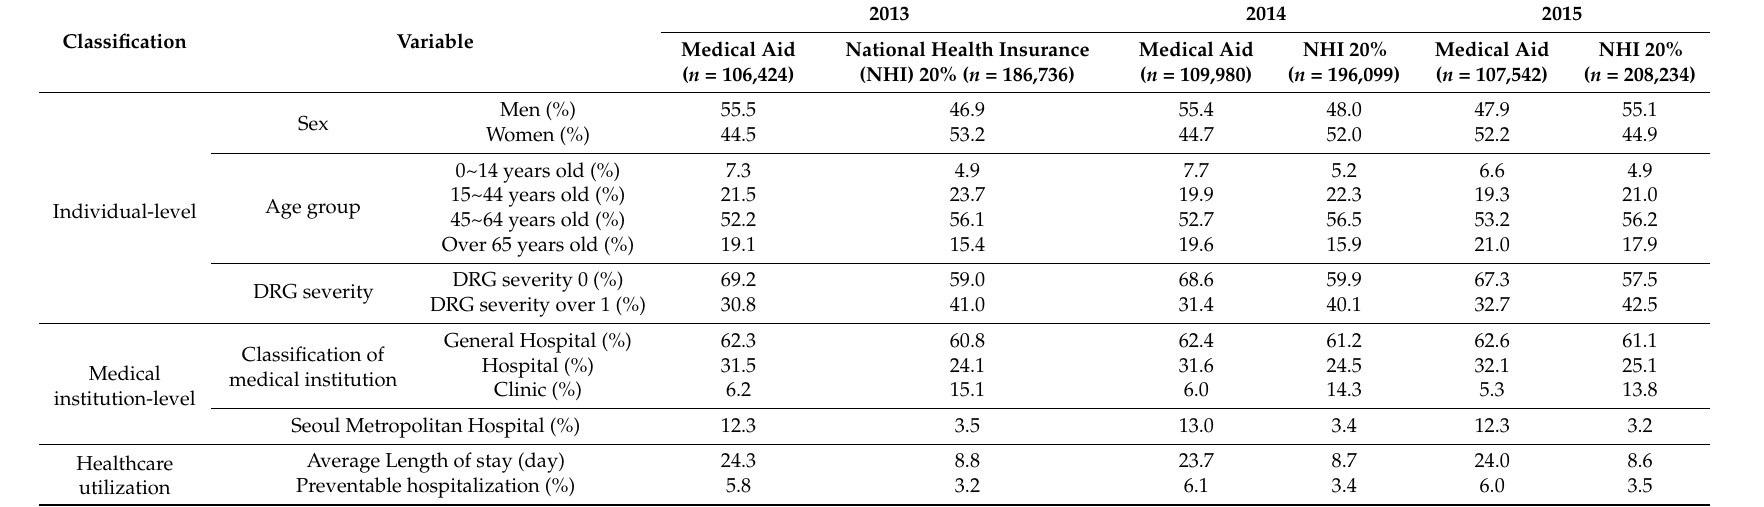
Table 1. Descriptive characteristics of study sample, length of stay, and preventable